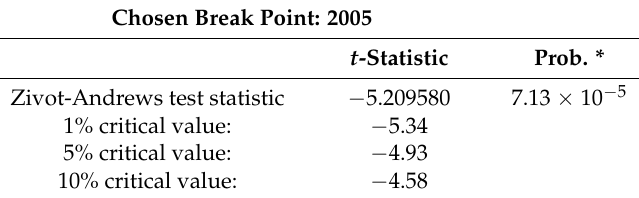
Table 4. Zivot-Andrews Unit Root Test results.